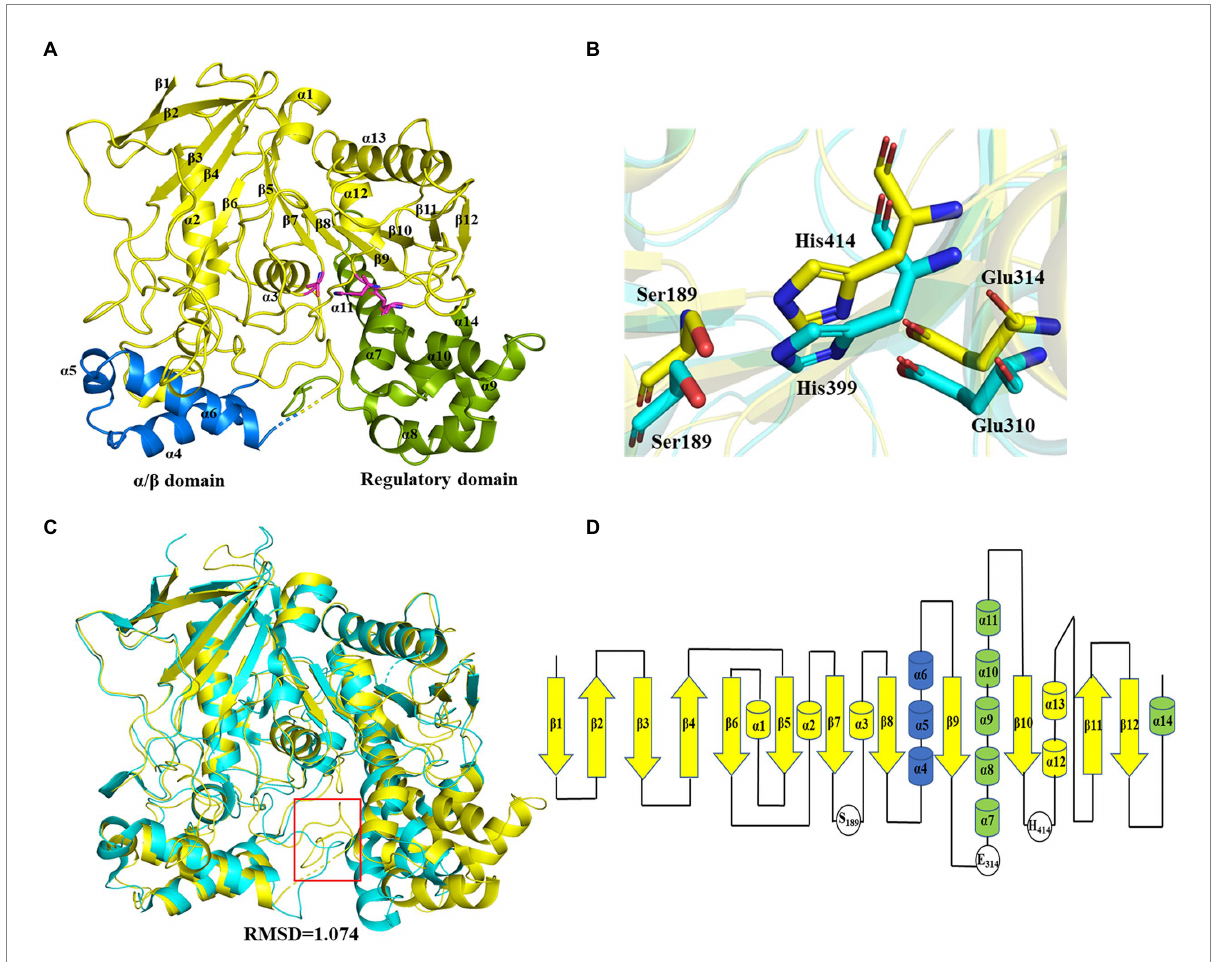
FIGURE 3 Crystal structure of E93 and structure comparison with microbial family VII carboxylesterases. (A) Global structure of E93. The structure contains three domains, including the catalytical domain (yellow), α / β domain (blue), and regulatory domain (green). (B) Conformational comparison of the catalytic triad of E93 (S189, E314, and H414; yellow) with that of pnbCE (S189, E310, H399; cyan). (C) Crystal structure comparison of E93 (yellow, PDB code: 7X8L) with pnbCE (cyan, PDB code: 1QE3). E93 and pnbCE are structurally homologous proteins. The RMSD value of E93 and pnbCE is 1.074 (C α 328). The unique loop (271aa-277aa in E93 and 268aa-274aa in pnbCE) was shown in red box. (D) Structural topology of E93. The color scheme is consistent with that of Figure